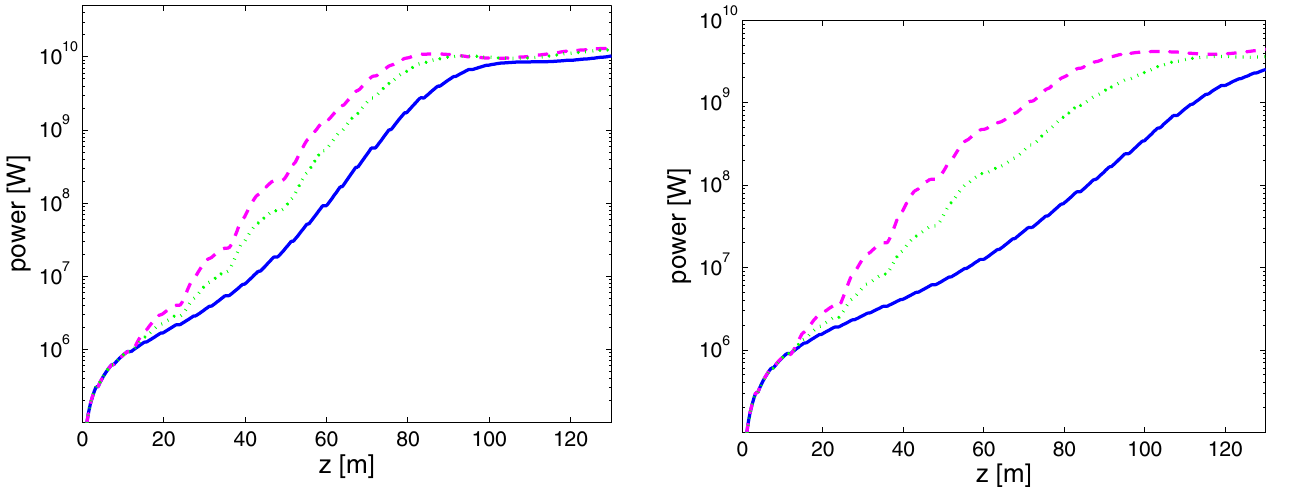
FIG. 3. (Color) SASE FEL power along the undulator without any optical klystron (blue solid curve), and with 4 optical klystrons for the initial rms energy spread of 1 (cid:9) 10 (cid:2) 5 (magenta dashed curve) and 5 (cid:9) 10 (cid:2) 5 (green dotted curve). The FEL wavelength is 1 : 5 (cid:1)A , and the undulator parameter K (cid:1) 3 : 5